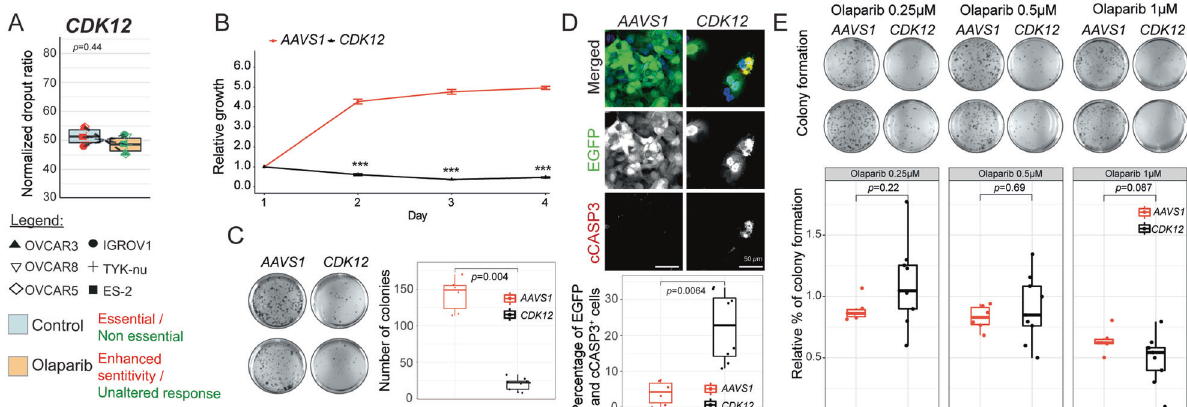
Fig. 5 CDK12 is an essential gene for ovarian cancer cell fi tness without altering olaparib sensitivity. A Boxplot summarising the unaltered response to olaparib in six EOC cell lines upon CDK12 editing. B Line chart and C boxplot showing a signi fi cant decrease in cell growth and colony formation capacity in CDK12 -edited OVCAR8- Cas9 + cells. D Representative immuno fl uorescence images and the corresponding quanti fi cation with a signi fi cant increase in the percentage of apoptotic cells (cCASP3 + ) in CDK12 -edited OVCAR8- Cas9 + cells. E Colony formation with quanti fi ed colonies for dose-dependent survival upon deletion of AAVS1 and CDK12 in OVCAR8- Cas9 + derived from at least two independent experiments, p -values are calculated by Wilcoxon test, *** p <